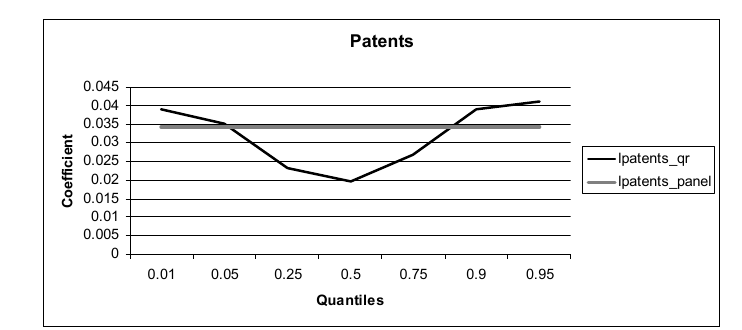
Figure 12 – Quantile Regressions versus Panel Regression estimates for Exporters: